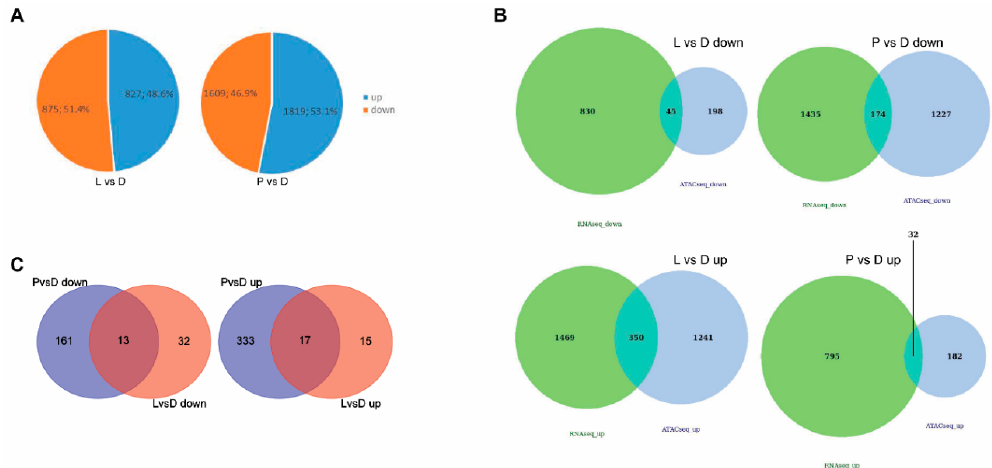
Figure 3. Integration of ATAC-seq and RNA-seq results. ( A ) Statistical pie chart of differentially expressed genes identified using RNA-seq. ( B ) Overlap of differentially expressed genes identified by ATAC-seq and RNA-seq. ( C ) Overlap of differentially expressed genes in the P vs. D and L vs. D groups.